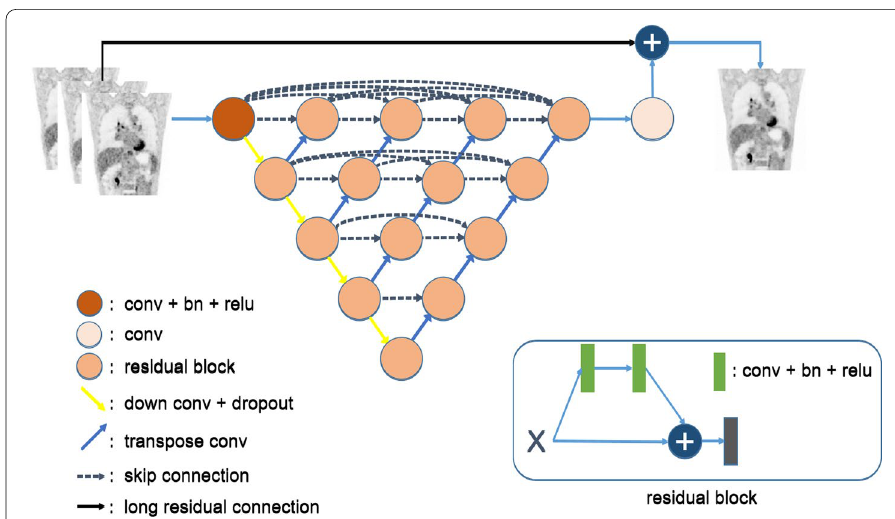
Fig. 1 Network architecture of HYPER DLR. relu: An activation function defined as the positive part of its argument: f ( x ) max(0, x ), where x is the input to a neuron. conv: Convolution is the most basic operation = in convolutional neural networks. The input image is convolved with the network to extract features in